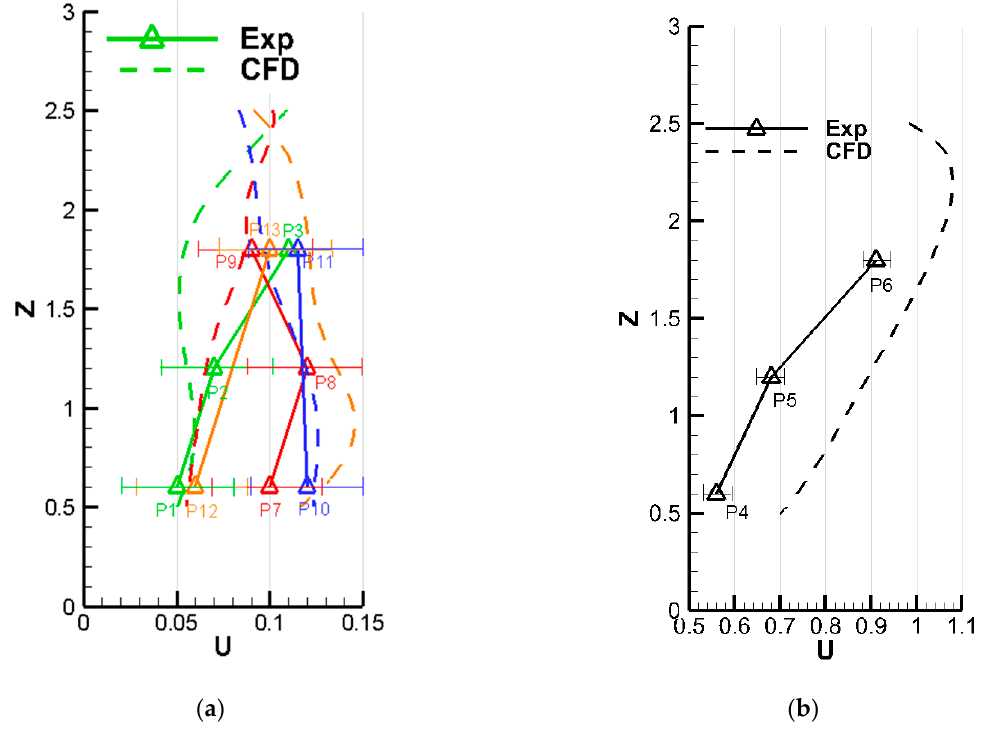
Figure 5. Comparison between experimental measurements and computational results for case B (( a ) and ( b ) were along the z-axis, which passed different measurement points. The same color represents the same location, Exp: Experiment, CFD: computational fluid dynamics).